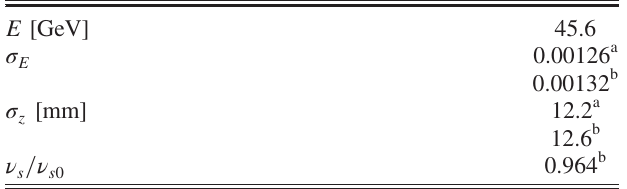
TABLE IV. The FCC-ee beam energy spread and length as well as the synchrotron tune parameter due to the combined effect of SR, BS, and PWD.